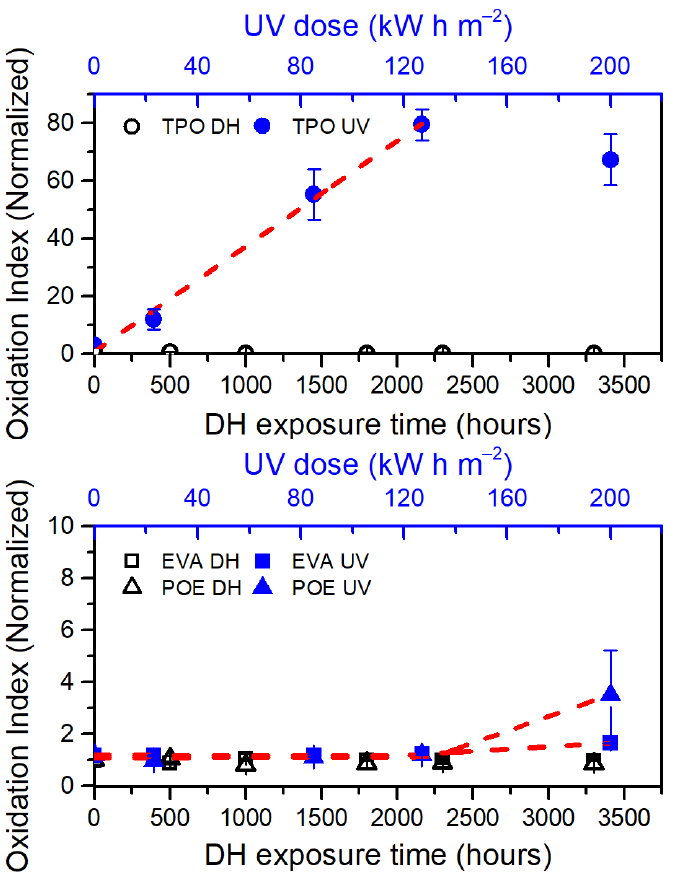
Figure 7. Oxidation Index (OI) versus exposure time (DH test, open symbols in black color) and dose (UV test, full symbols in blue color). Red dashed lines are fitting functions applied to the data to extrapolate the oxidation induction time/dose. TPO (top chart), EVA and POE (bottom chart). The samples exposed to DH test did not show any substantial change, whereas